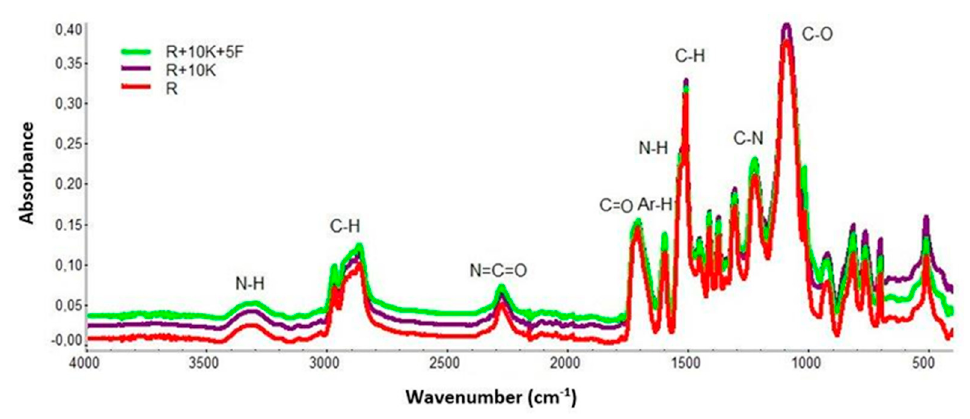
Figure 2. Comparison of Fourier transform infrared (FTIR) spectra of samples modified with keratin and Fyrol PNX.